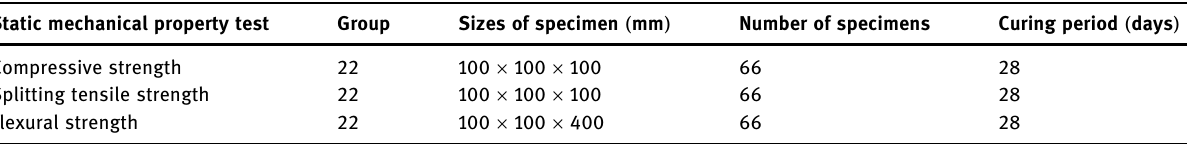
Table 7: Design of the